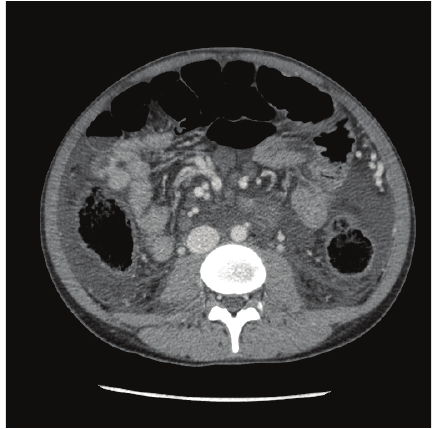
Figure 1: Axial view of abdomen showing ascites.